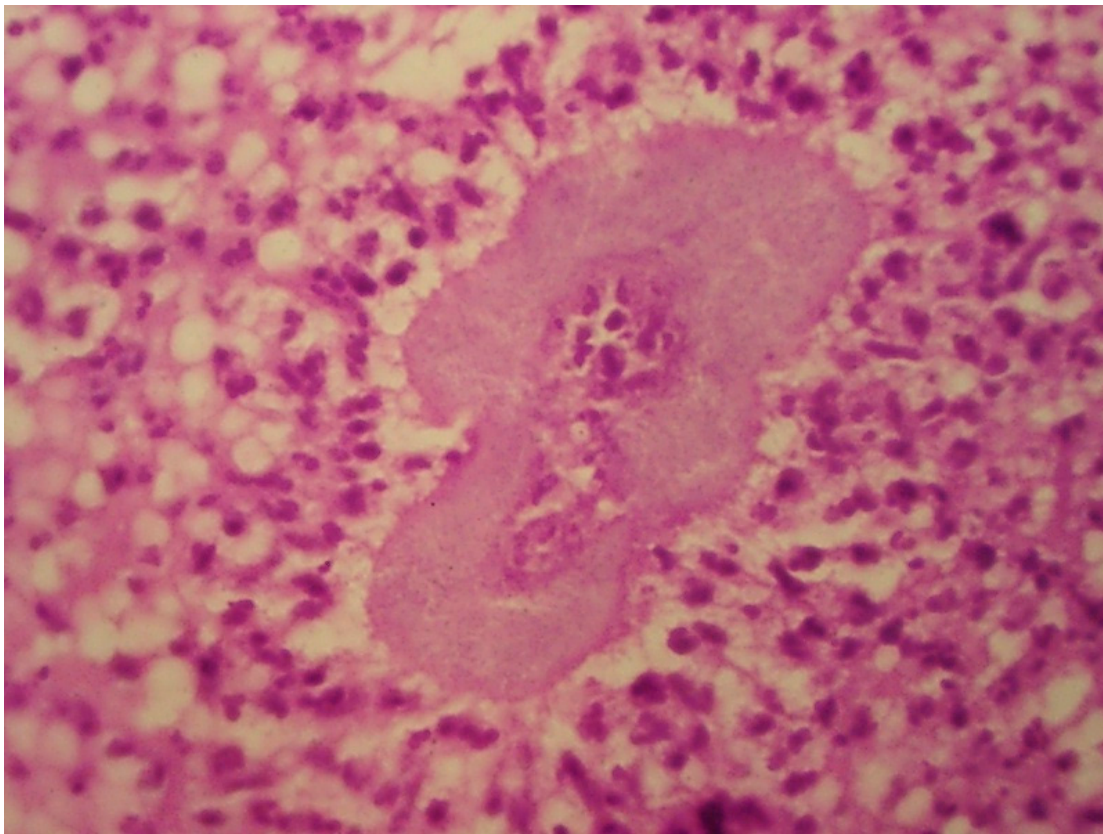
Figure 1. Eumycetoma of the foot.